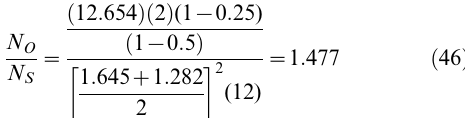
ffiffiffiffiffiffiffiffiffiffiffiffiffiffiffiffiffiffiffiffi z y 2 y 2 Eb